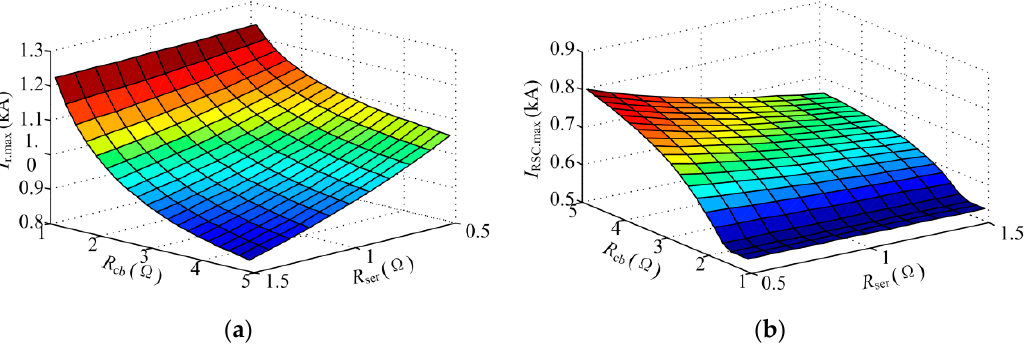
Figure 9. Calculation results under different parameters. ( a ) The maximum of the rotor current; and ( b ) the maximum of the RSC current.